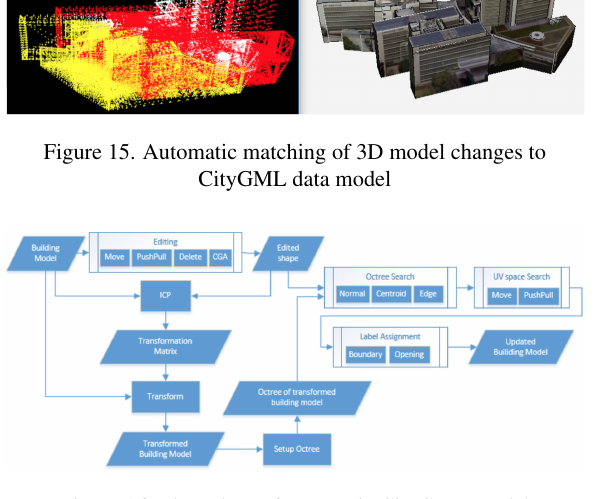
Figure 16. Flow chart of automatic CityGML model